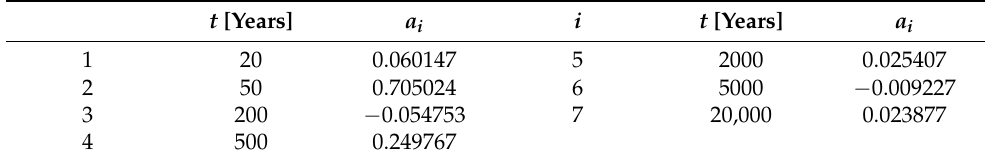
Table 1. Parameters of time and coefficient ( a i ) used in power computation for heat decay. t [Years] a i